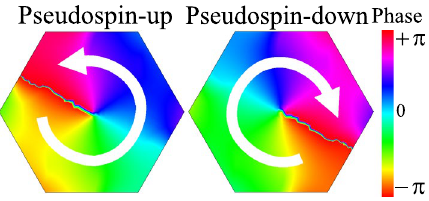
Figure 3. Circular polarization of the magnetic field related to the pseudospin modes ( H psedusospin up presents an anticlockwise circular polarization, while pseudsospin down presents a clockwise circular polarization. (We used COMSOL Multiphysics v.6.0. www. comsol. com. sofware to create the image).